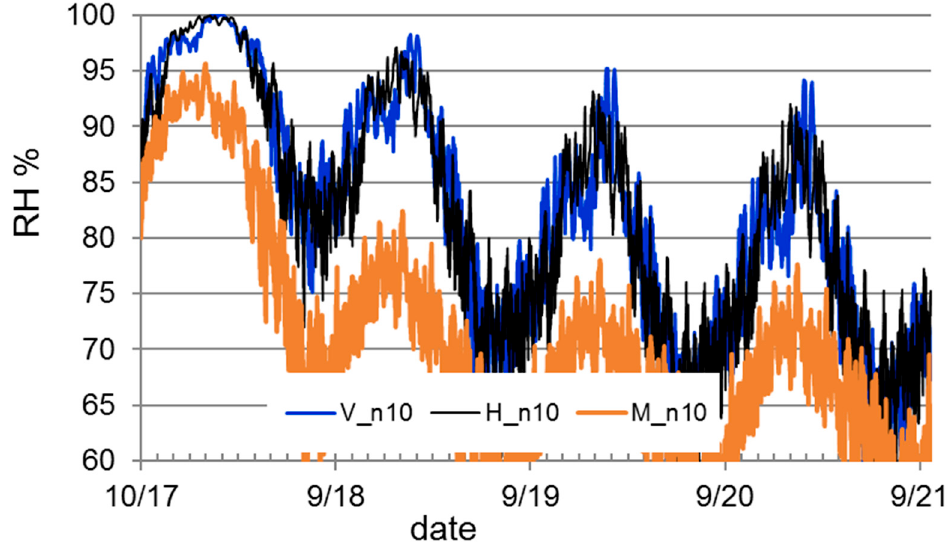
Figure 12. Brick wall, ventilation scheme 1, n = 10 1/h, normal dry initial conditions (80% RH). The solved relative humidity in the boundary between mineral wool back layer insulation and the PU-insulation of the panel in three different climates during the four-year simulation period.